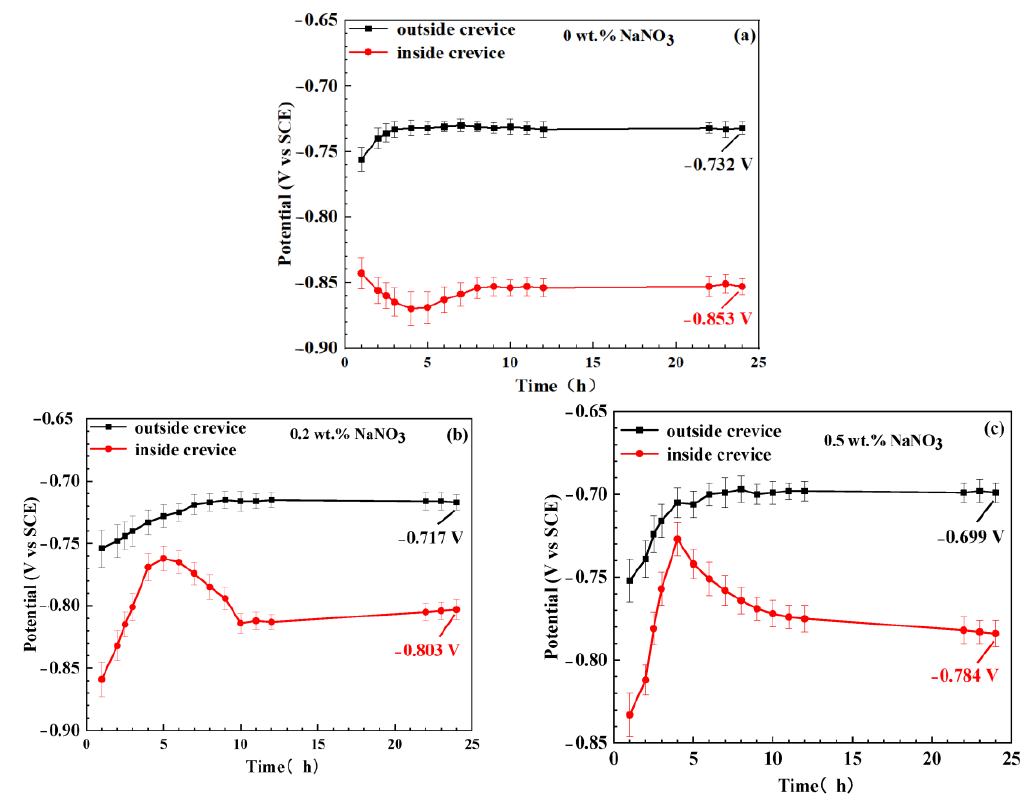
Figure 3. The OCPs of specimens inside and outside the crevice in solutions with different concentrations of NaNO 3 after corrosion for 24 h. ( a ) 0 wt.% NaNO 3 , ( b ) 0.2 wt.% NaNO 3 , ( c ) 0.5 wt.% NaNO 3 .